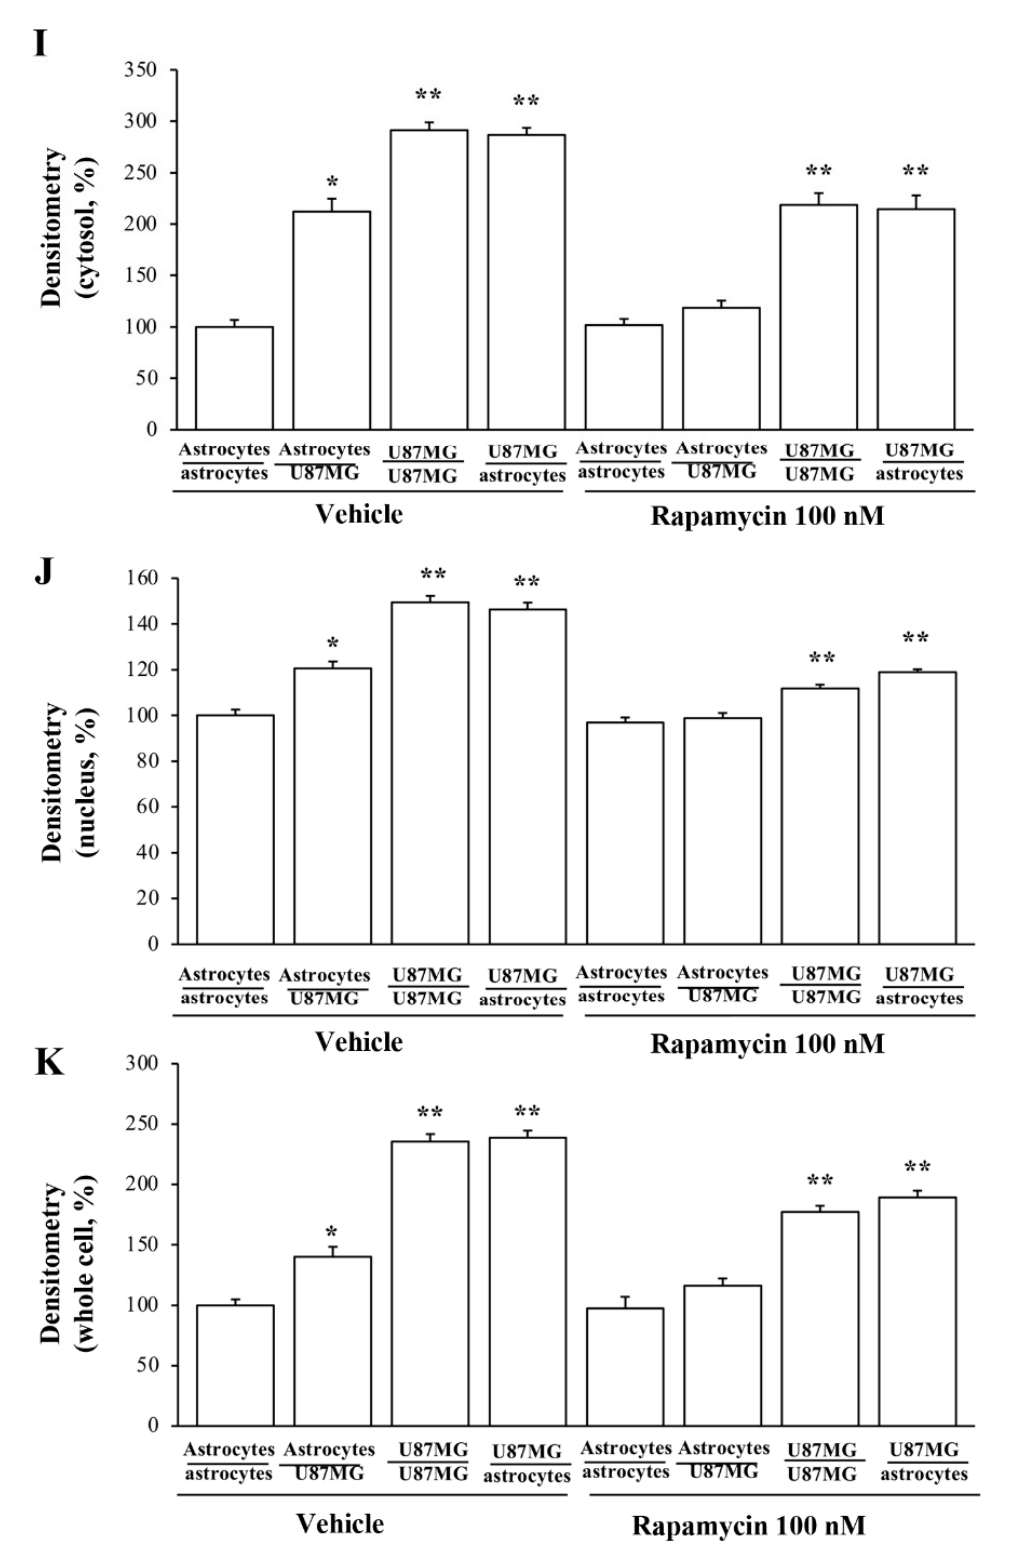
Figure 13. α -Syn immuno-cytochemistry in co-cultures of astrocytes and GBM cells, both in baseline conditions and following rapamycin administration. Upper panels report representative pictures of α -syn immuno-cytochemistry within astrocytes co-cultured with astrocytes ( A ), astrocytes co-cultured with GBM cells ( B ), GBM cells co-cultured with GBM cells ( C ), and GBM cells co-cultured with astrocytes ( D